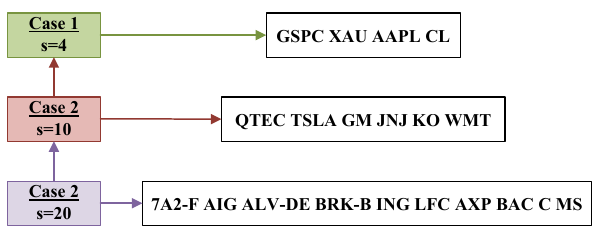
Figure 1. The portfolio cases stocks that have been utilized in the CT MVPO problems experiments.